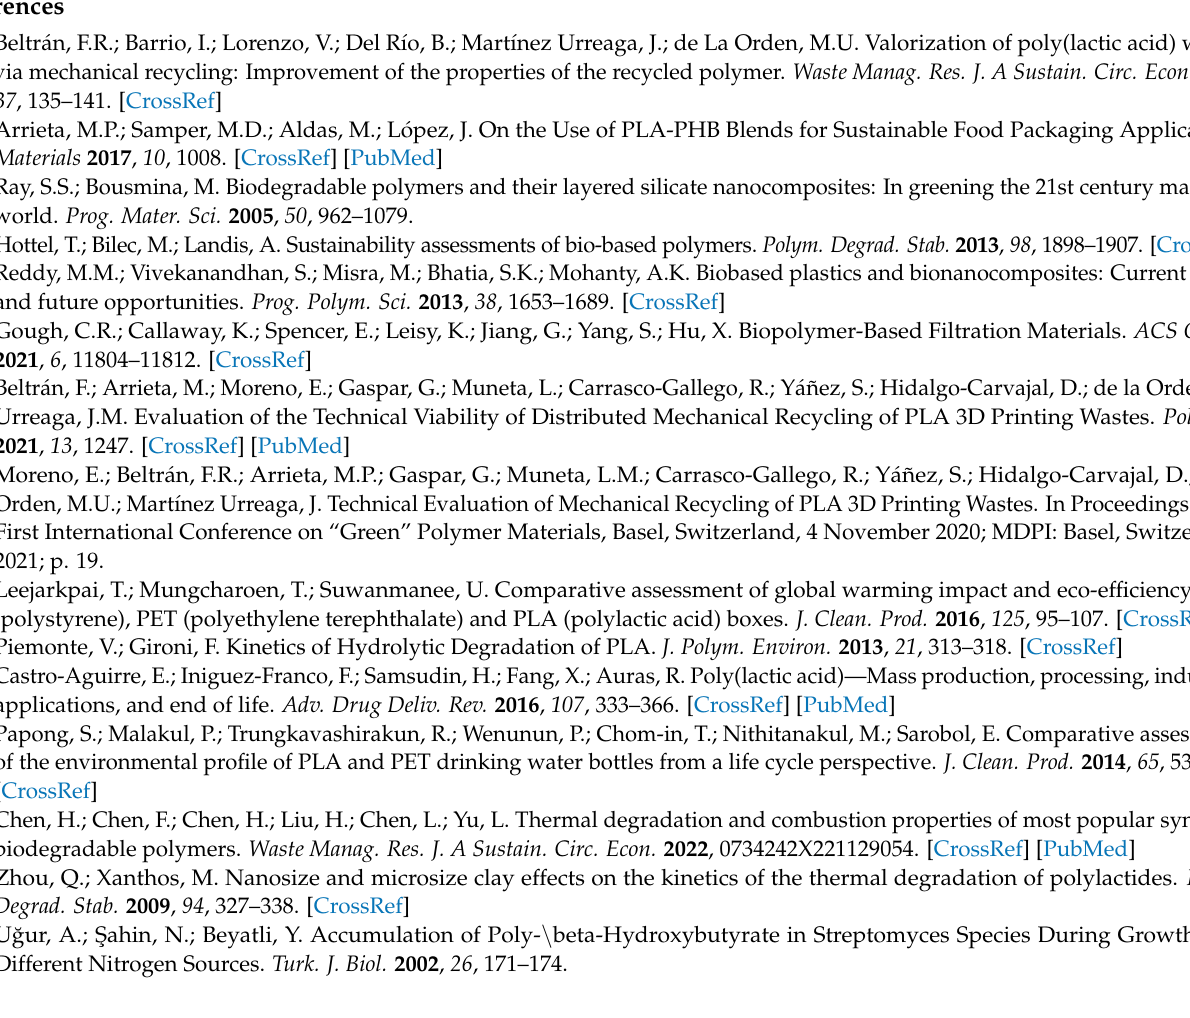
Figure S15: 13 C NMR spectrum of methacrylated methyl 3-hydroxybutyrate (M3HBMMA). 13 C